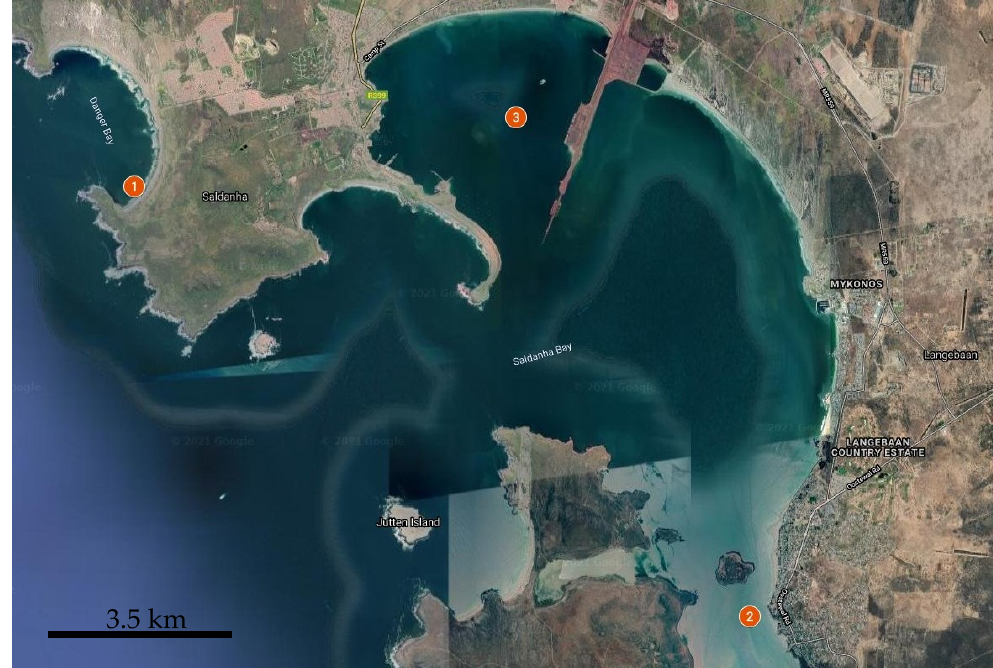
Figure 1. Collection sites in Saldanha Municipality area: St. 1—Danger Bay, St. 2—Langebaan Yacht club, St. 3—Small bay. St. 1. Danger Bay was chosen to represent the features of wild mussels, which grow in a pristine tidal zone and are exposed to waves and